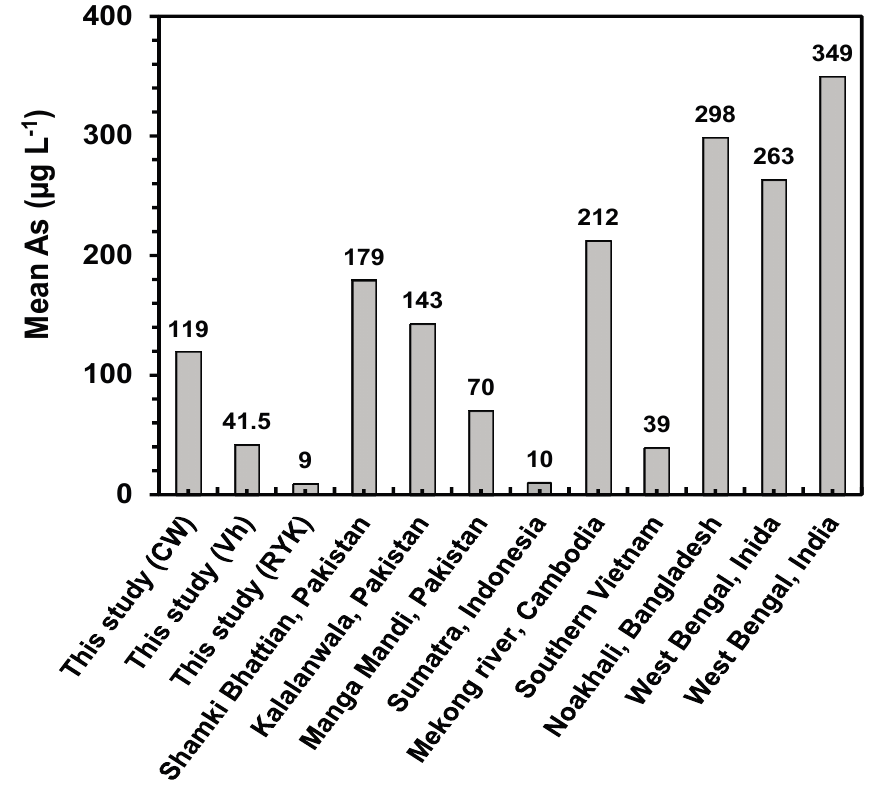
Figure 2. Comparative mean As concentrations (µg·L − 1 ) in groundwater recorded in this study with other studies conducted in Pakistan (Sultana et al. [24]), Indonesia (Wnikle et al. [46]), Cambodia (Buschmann et al. [47]), Vietnam (Buschmann et al. [47]), Bangladesh and India (Rahman et al.